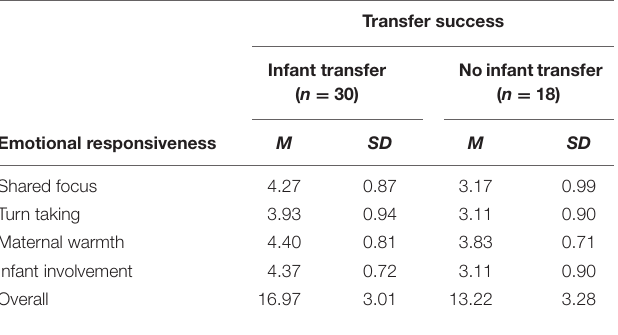
TABLE 2 | Mean emotional responsiveness ratings by infant transfer success.